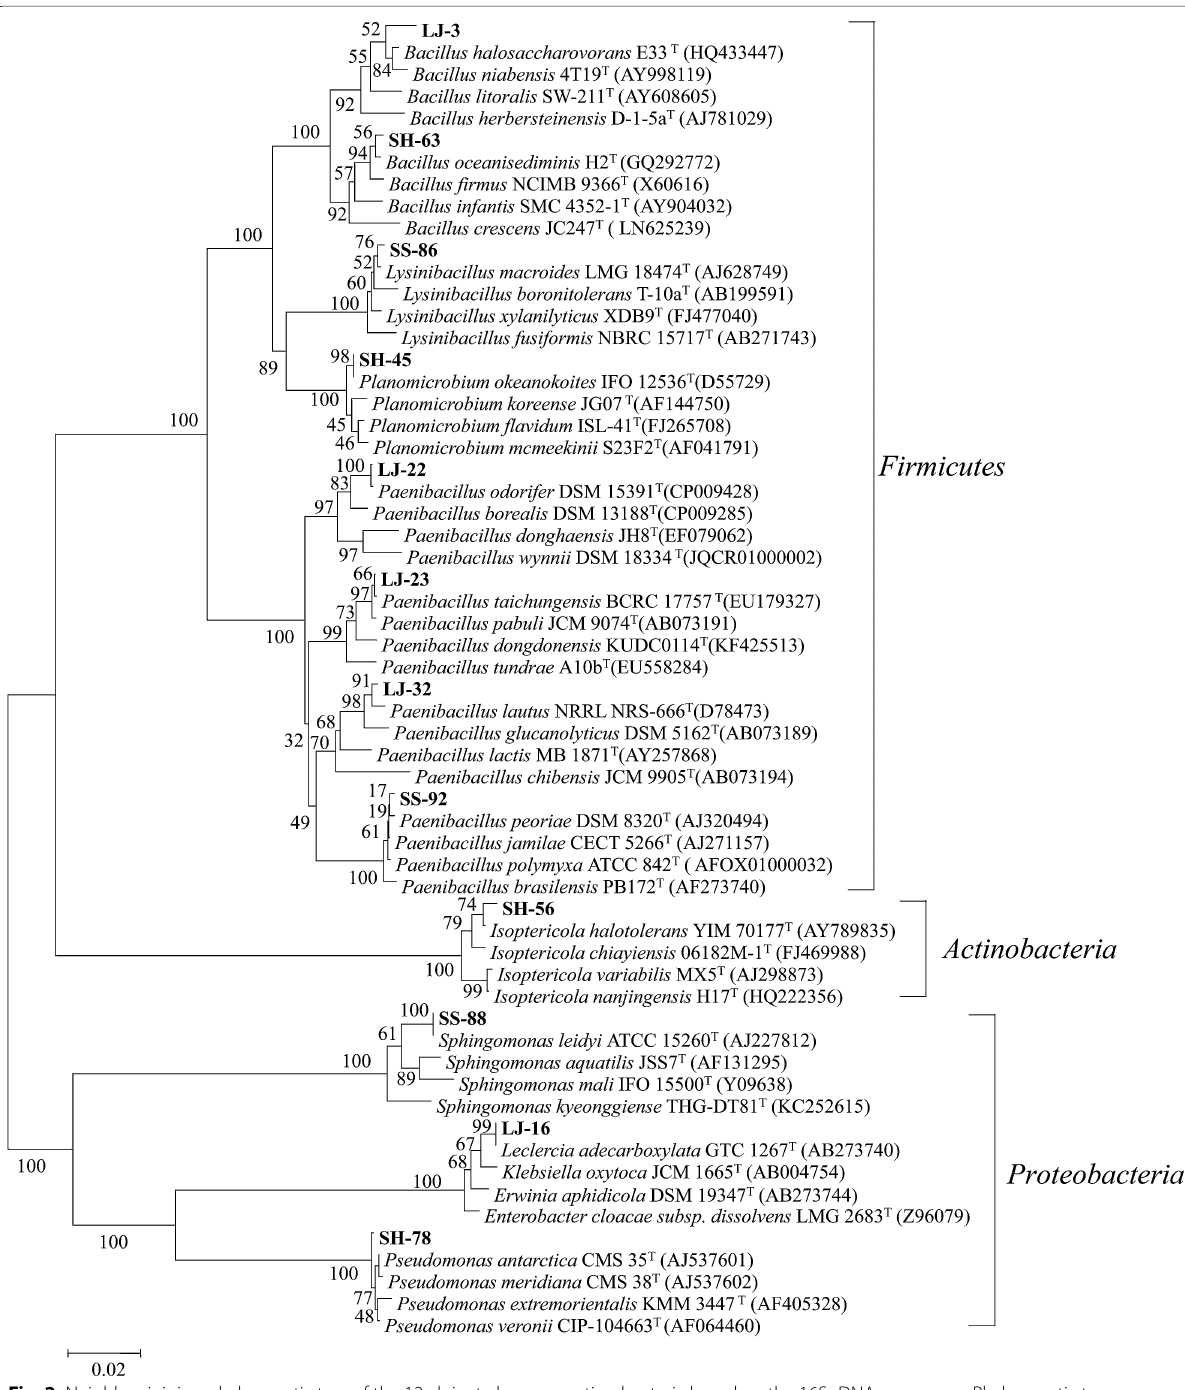
Fig. 2 Neighbor-joining phylogenetic tree of the 12 alginate lyase-excreting bacteria based on the 16S rDNA sequences. Phylogenetic tree was constructed using neighbor-joining method with bootstrap (1000 replicates) by Kimura 2-parameter model using MEGA 5.1